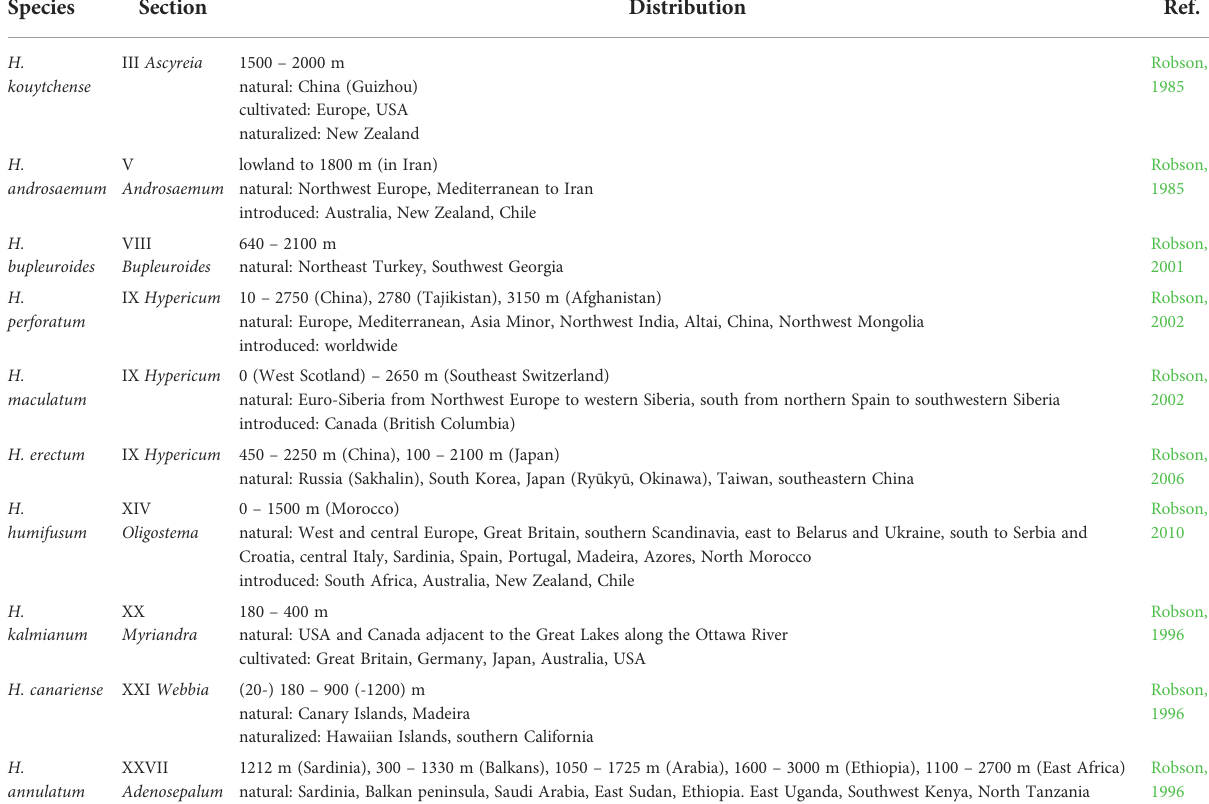
TABLE 1 Worldwide distribution of 10 Hypericum species used in the study. Species Section Distribution